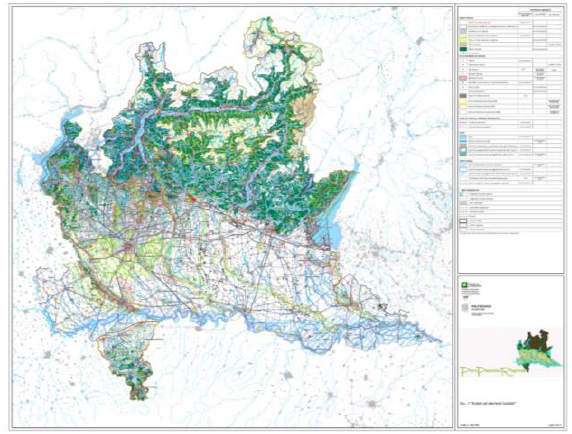
Figure 1. Lombardy Region Landscape Plan (PPR), review: landscape preservation system. 52% of Lombardy Region is under landscape protection at international, national or regional